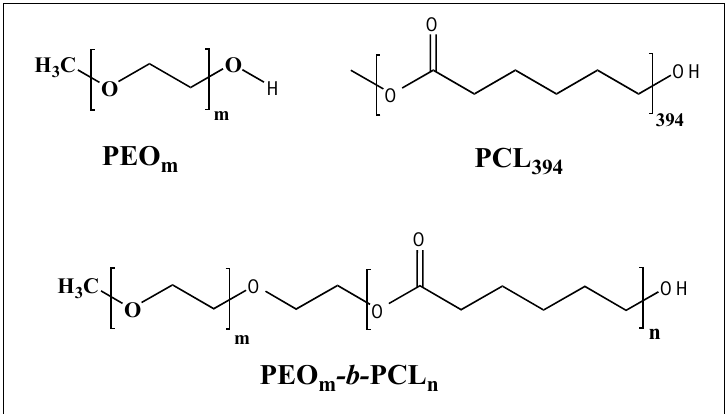
Figure 1. Molecular structures of polymers studied.